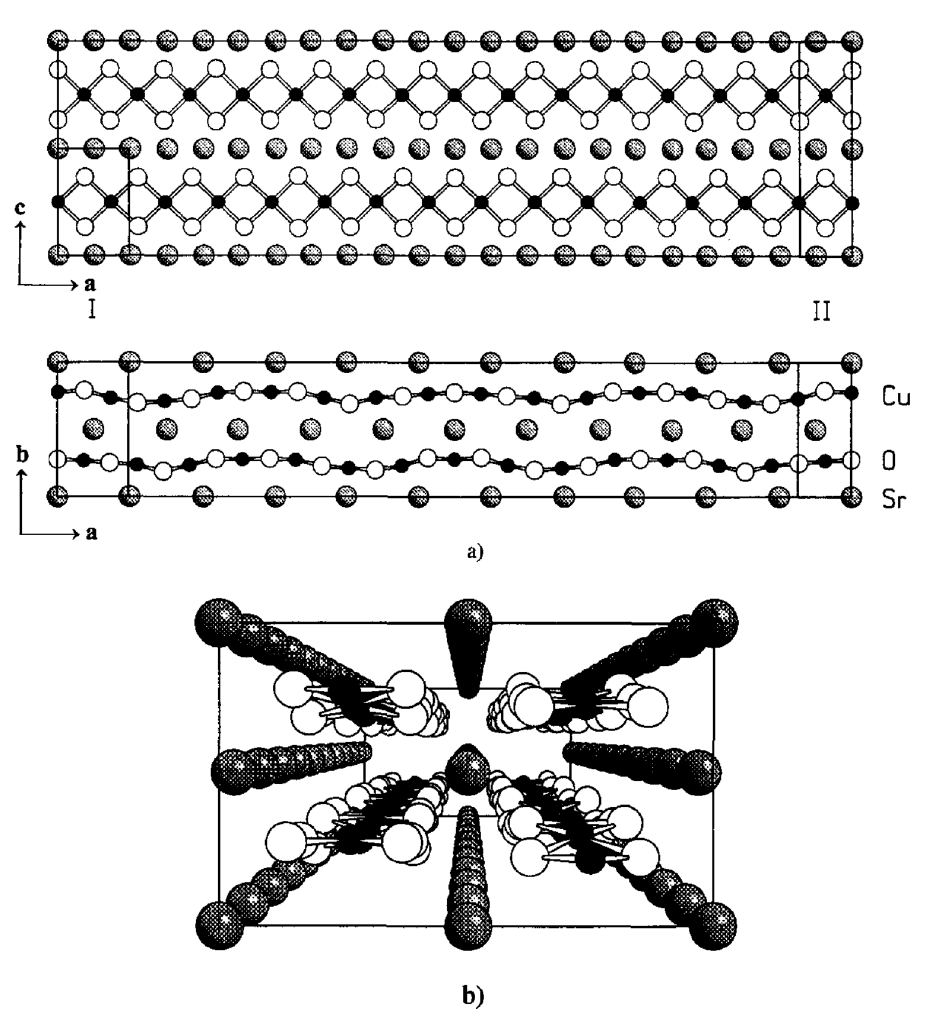
Figure 7. ( a ) Structure of Sr0.73CuO2 consisting of one-dimensional edge-sharing CuO2 chains alternating with Sr planes. CuO2 chains are wave-modulated. I: subcell of Sr atoms. II: subcell of Cu and O atoms. ( b ) Perspective view of the Sr0.73CuO2 structure in a direction.